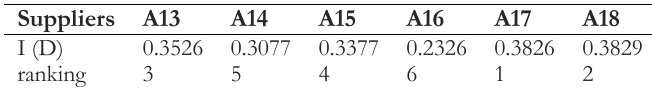
Table 4. Ranking of suppliers of parts category B.